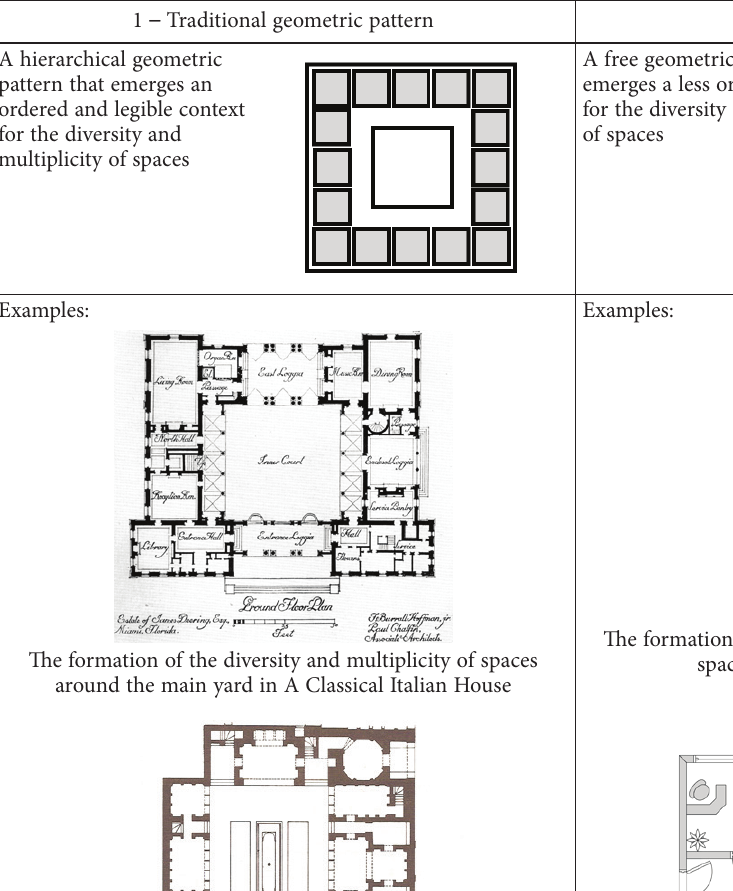
ordered and legible context for the diversity and multiplicity of spaces